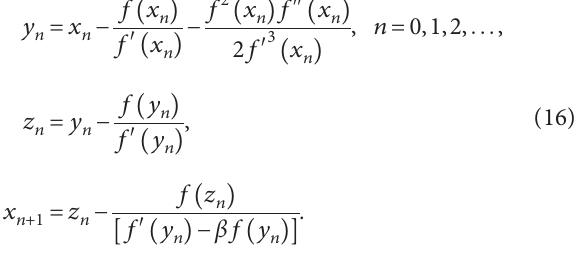
Algorithm 1. For a given x